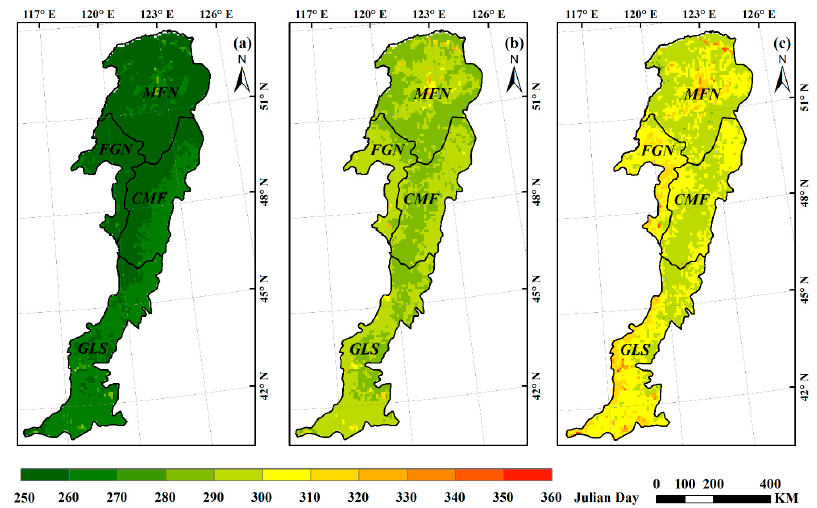
Figure 4. Spatial patterns of multiyear averaged EOS derived from three methods: maximum slope method ( a ); dynamic threshold method ( b ); and inflection=based method ( c ).